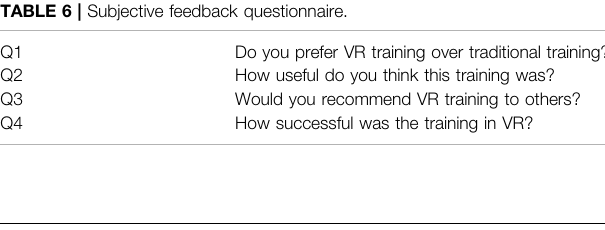
TABLE 7 | Perceived learning questionnaire.